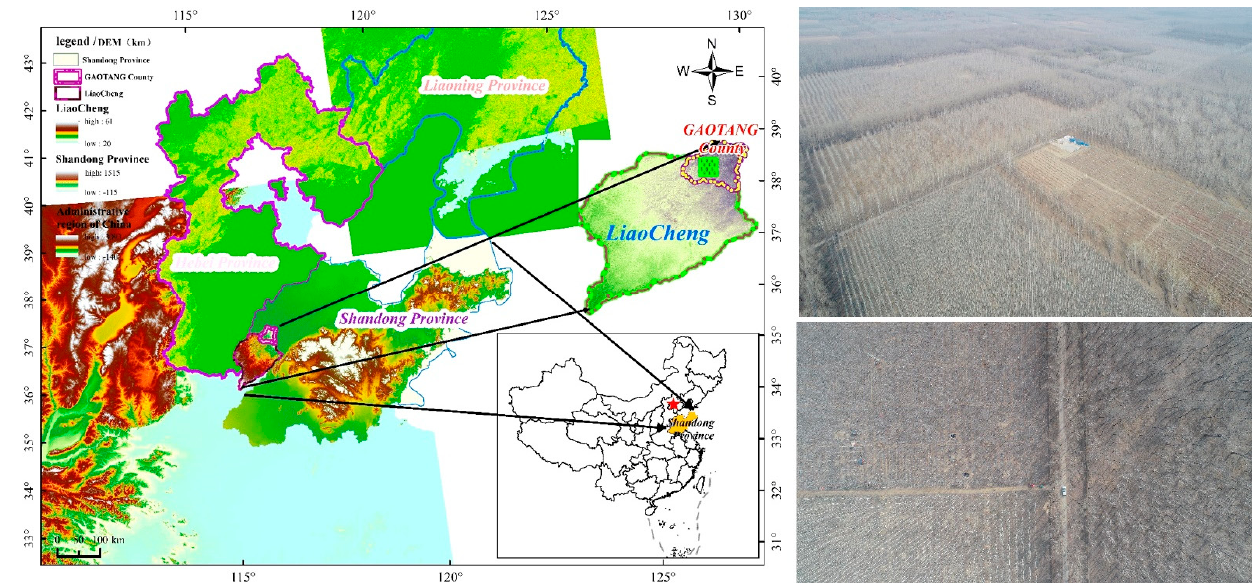
Figure 1. Aerial photograph of the study location and Forest Farm. Table 1. Basic physical and chemical properties of the soil at the test site.